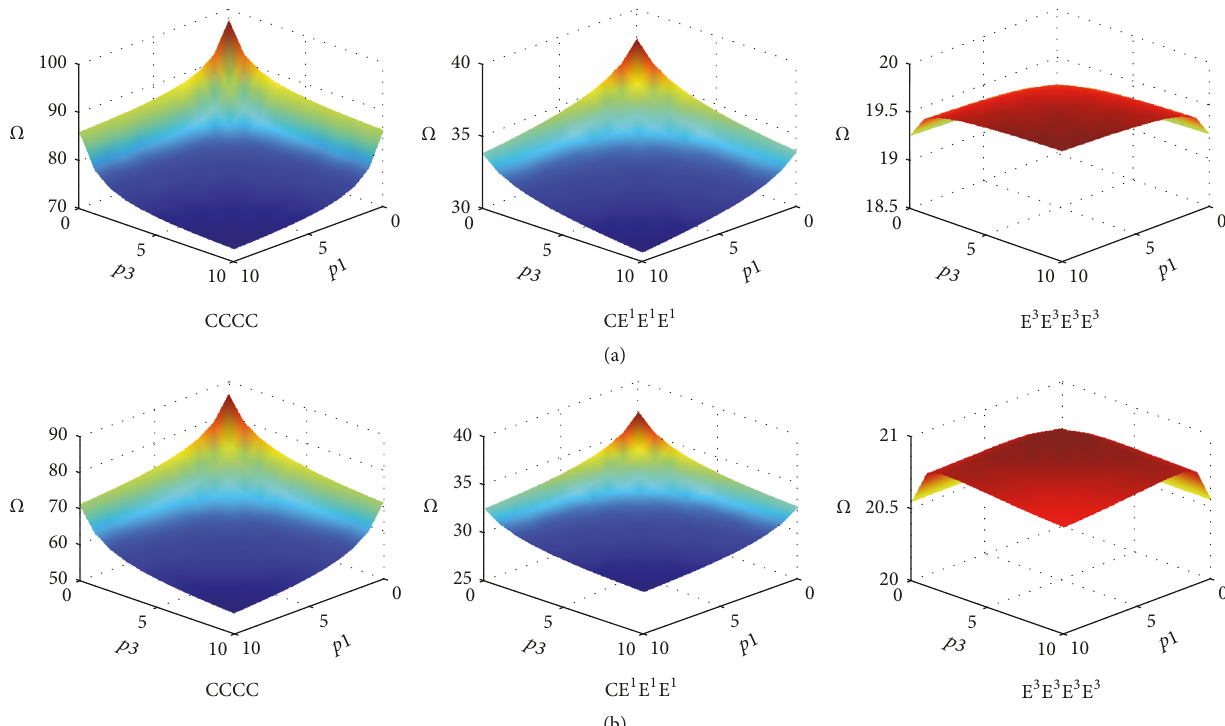
Figure 8: Variations of fundamental frequency parameter Ω of Type 1 annular sector plate against different power-law exponents: (a) Type 1-1 (1-2-1); (b) Type 1-2 (1-2-1).